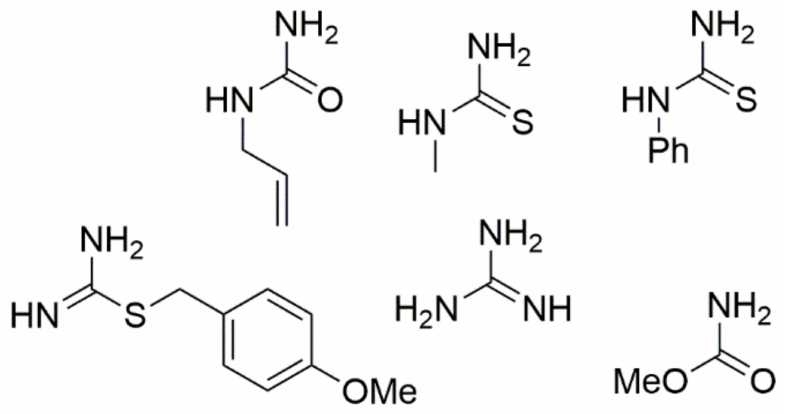
Figure 7. Structures of monosubstituted alkyl urea used for the synthesis of N1-substituted DHPMs. Thiourea and substituted thioureas follow the same general rules. However, longer reaction times are required to achieve good conversions. In some instances, it is also possible to use protected urea, thioureas, or guanidines under weak basic conditions with the aldehyde and CH-acidic carbonyl component (or with a precondensed Knoevenagel- type enone) to yield the corresponding protected DHPMs, as shown in Scheme 9. This latter method using precondensed enones has been frequently referred to as the “Atwal modification of the Biginelli reaction”. Twenty years ago, a huge number of DHPMs were synthesized and evaluated to determine their biological activities as antiviral; anti-tumor; antibacterial; anti-inflammatory; and, more recently, anti-hypertensive agents. In 2003, some Biginelli products were synthesized by Wageeh S. El-Hamouly et al. and screened to determine their antihypertensive activity (Figure 8). The findings obtained demonstrated that there was a strong anti-hypertensive activity in the series created using 4-chromonyl derivative. Among the synthesized compounds, the 4-chromonyl derivative showed a better anti-hypertensive potency than 4-pyrazolyl analogues and even than the standard drug nifedipine. With the aid of non-selective cat models, the group concluded that the dihydropyrimidines substituted with aryl functionalities were more potent than the dihydropyrimidones substituted with the same aryl